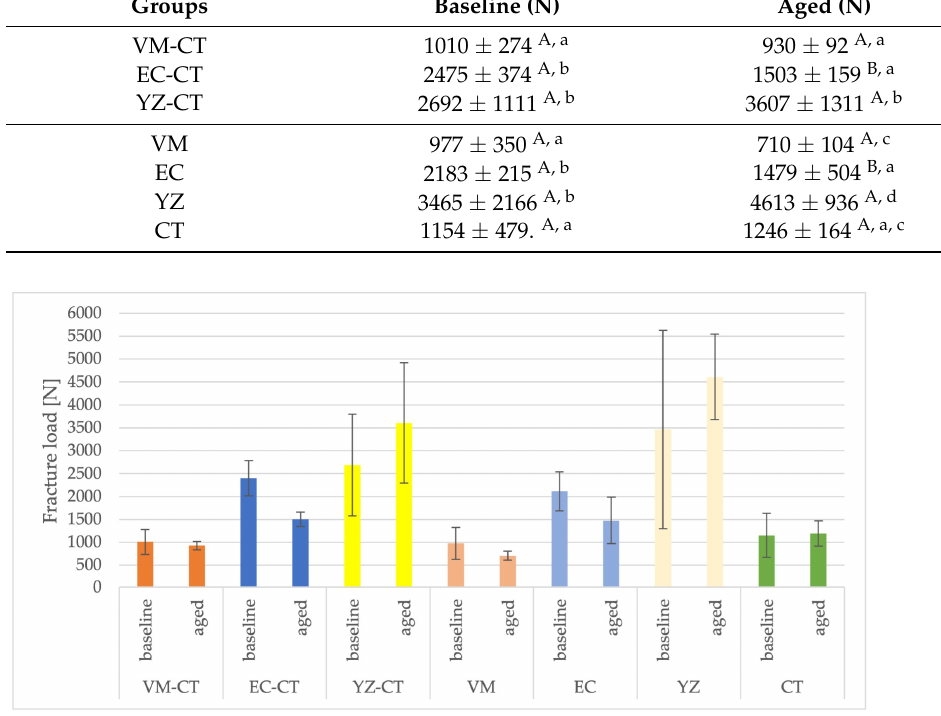
Figure 3. Fracture load values of the restorations ( n = 6 per group).